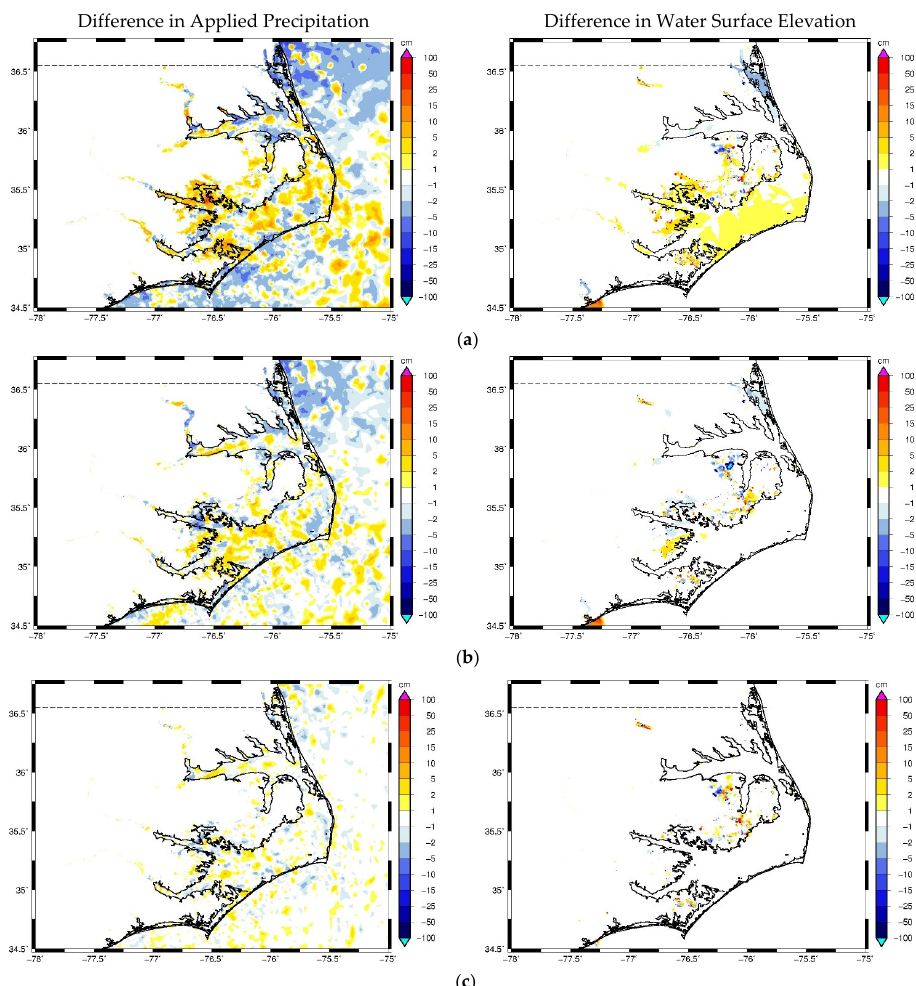
Figure 8. Difference plots of the applied precipitation (left-hand column) and resulting water elevations (right-hand column) during Hurricane Irene: ( a ) 60-min precipitation interval vs. 5-min precipitation interval, ( b ) 30-min precipitation interval vs. 5-min precipitation interval, ( c ) 15-min precipitation interval vs. 5-min precipitation interval. Note that all of the figures have the same scale, which does not have constant increments, and differences less than 1 cm are not shown.